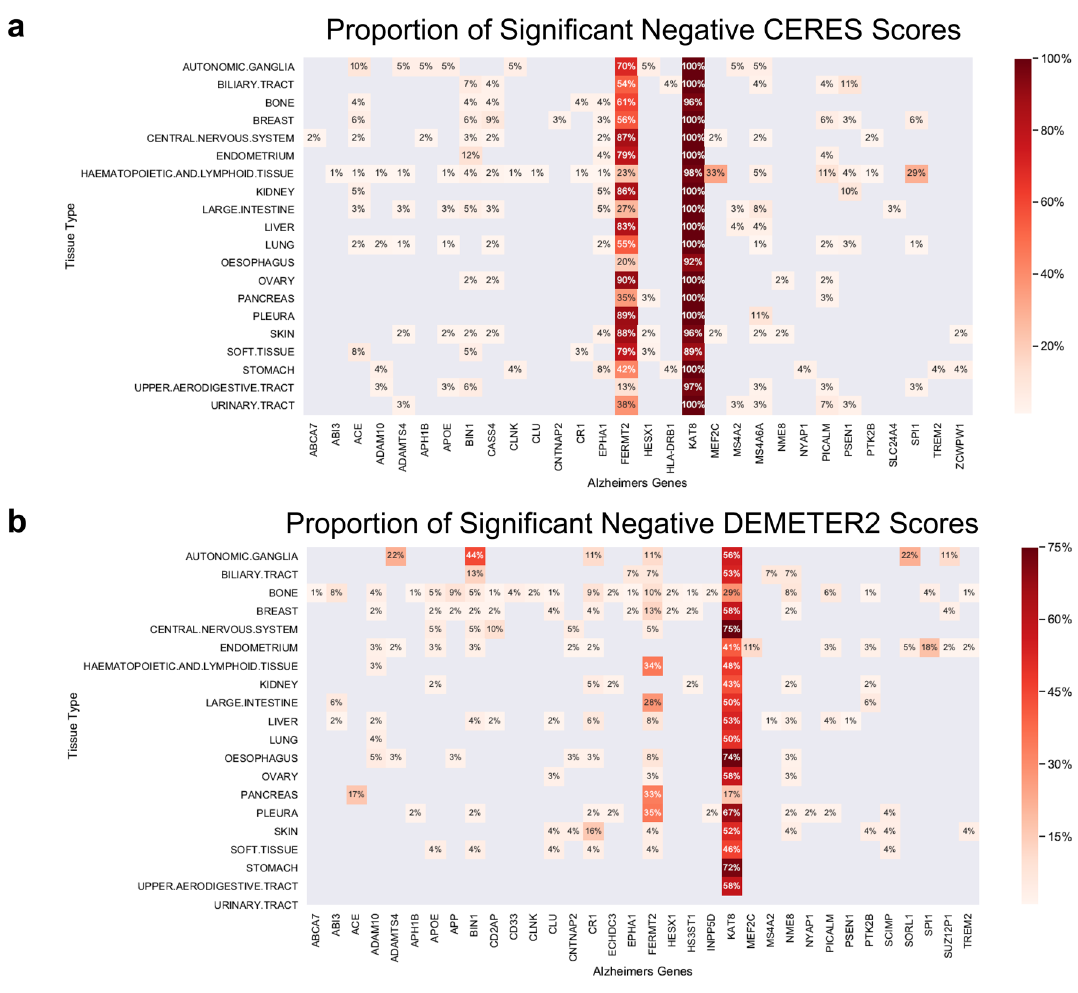
Figure 1. Genetic dependency of AD risk genes in CRISPR knockout and knockdown screens across tissue lineages. ( a ) The proportion of pass-DepMap-threshold negative dependency scores (< − 0.5) in cell lines by tissue types based on the CERES scores derived from CRISPR knockout screens. ( b ) The proportion of pass- DepMap-threshold negative dependency scores (< − 0.5) in cell lines by tissue types based on the DEMETER2 scores derived from RNAi knockdown screens. For both ( a ) and ( b ), 20 tissue types from the Cancer Dependency Map (DepMap) project with data for at least 25 cell lines were utilized to evaluate 44 AD risk genes. A negative dependency score indicates a gene’s necessity for a cell line’s growth and